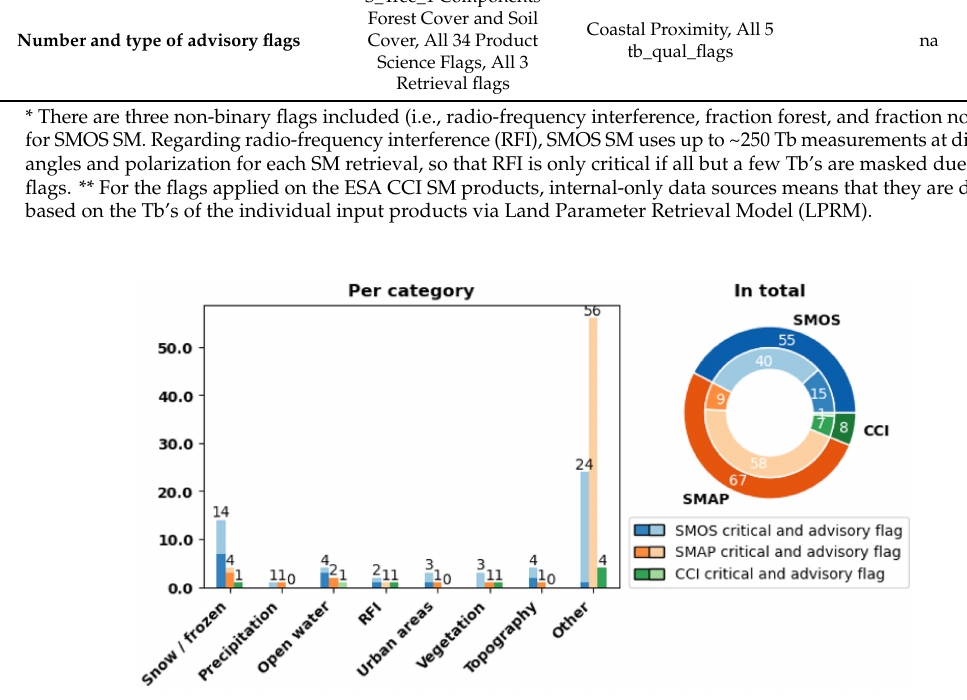
Figure 5. The number of critical (more opaque colors) and advisory (more transparent colors) flags of the sensor datasets SMOS and SMAP and the multi-sensor ESA CCI SM datasets per flagging category ( left ) and in total ( right